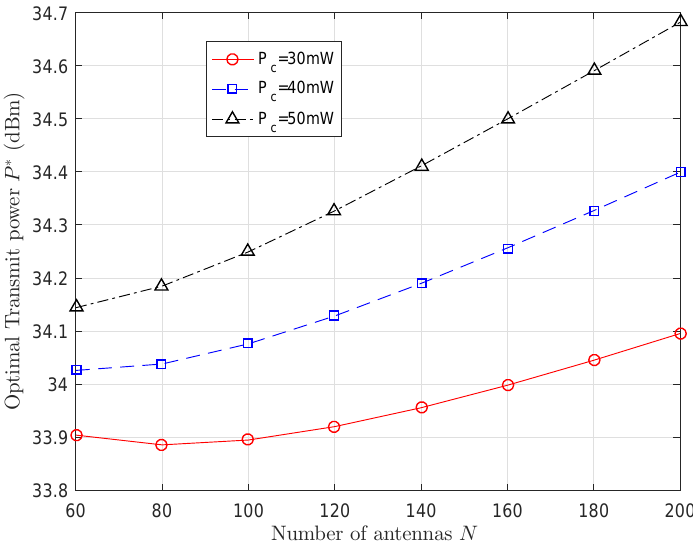
Figure 5. The optimal total transmit power versus the number of